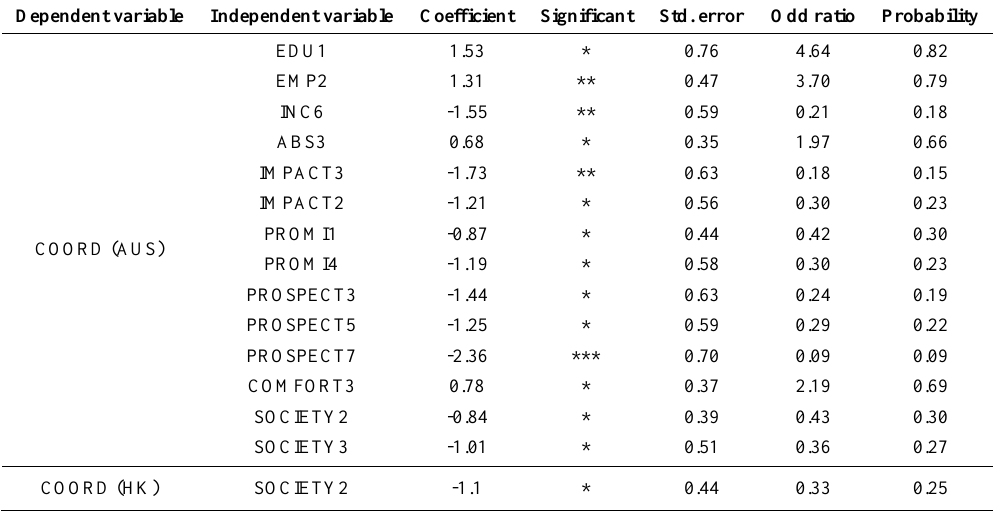
Table B-1. Limited project coordination for the AI implementation between other neighbouring local